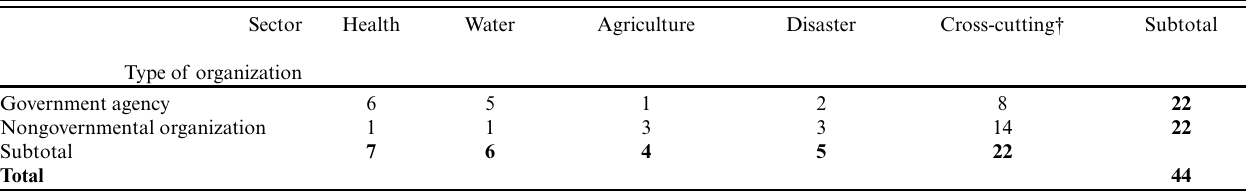
Table 2 . Stakeholder stratification by sector and